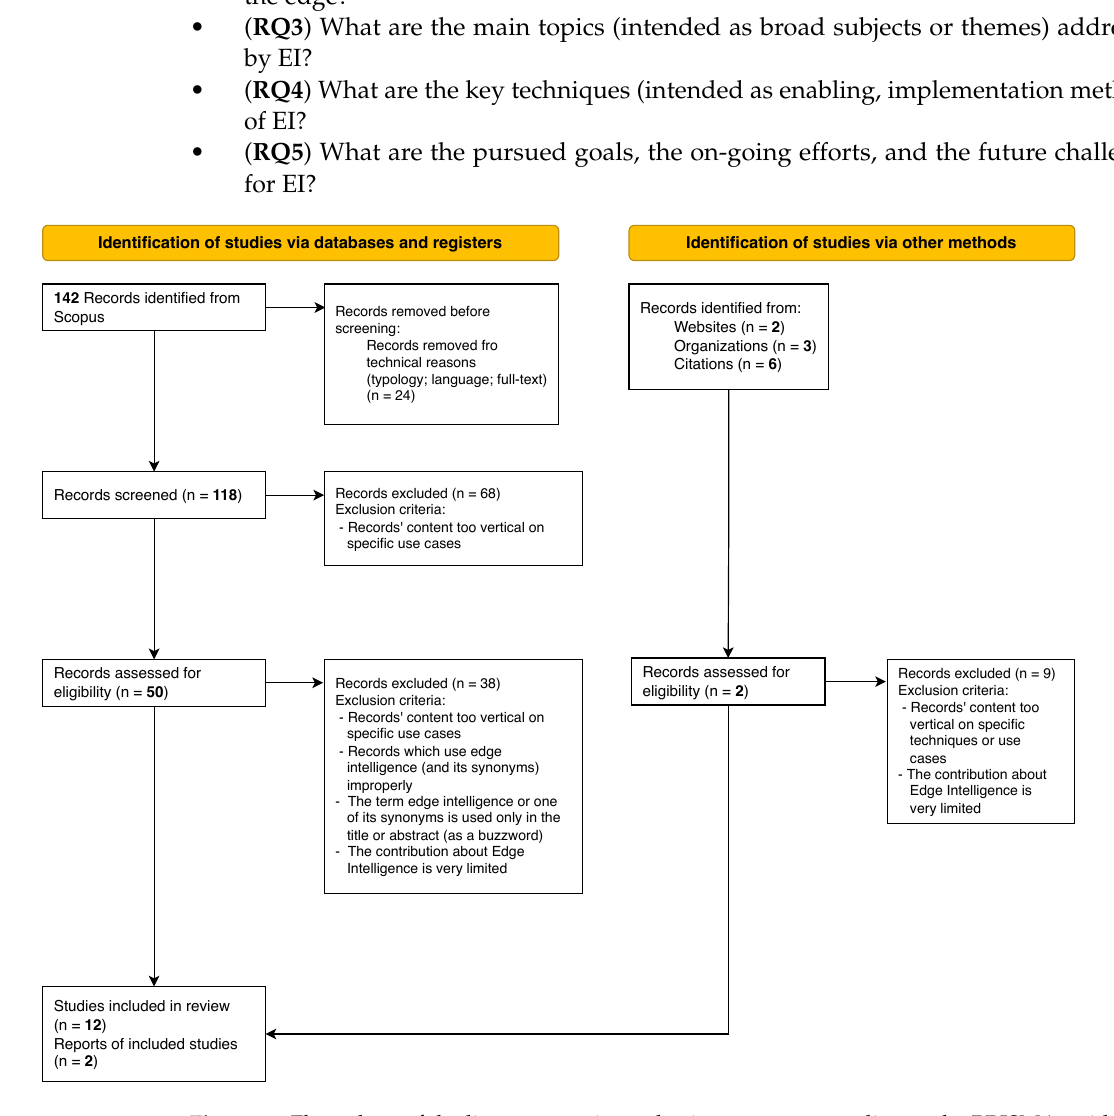
Figure 2. Flow-chart of the literature review selection process according to the PRISMA